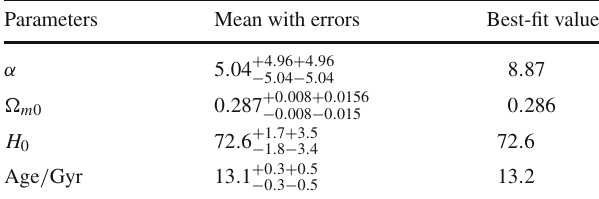
Table 1 This table summarizes the constraint results on the parameters α , (cid:7) m 0 , H 0 and derived parameter Age of scalar field DE model with n = 2 using the joint analysis of BAO, JLA and